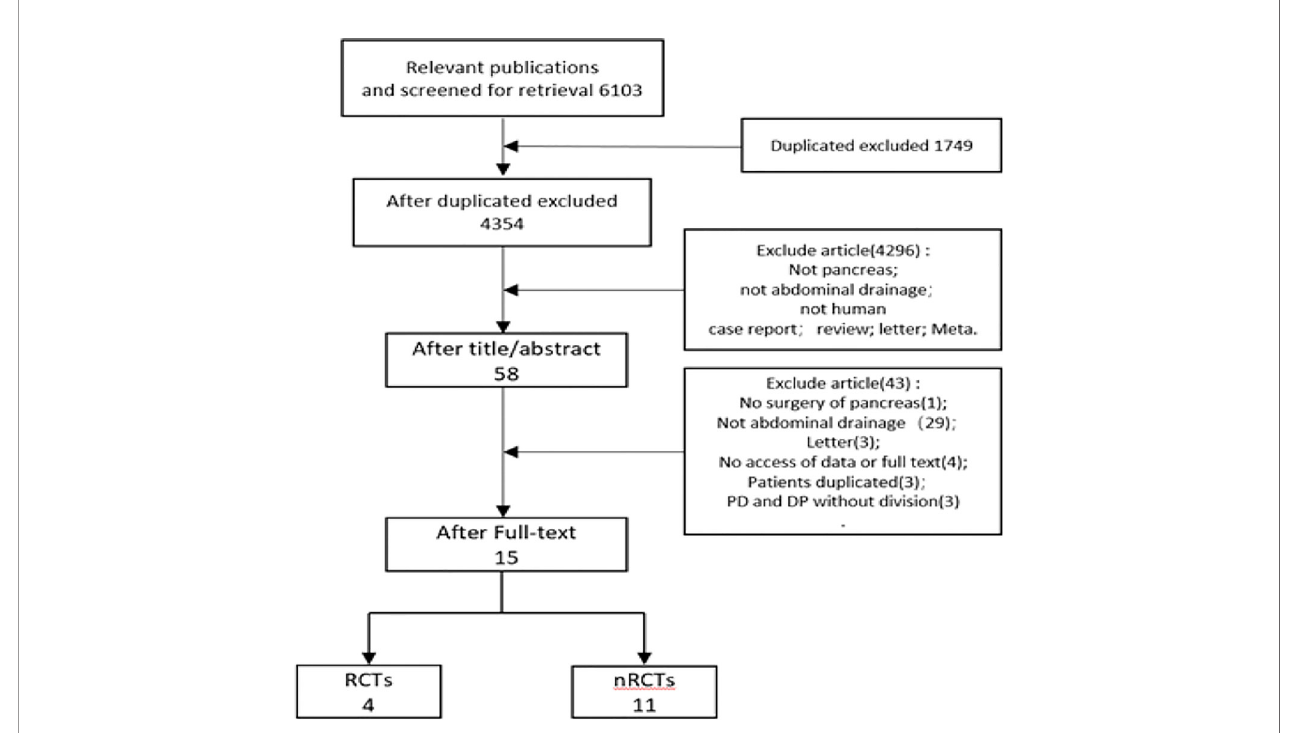
FIGURE 1 | Flow chart of literature search